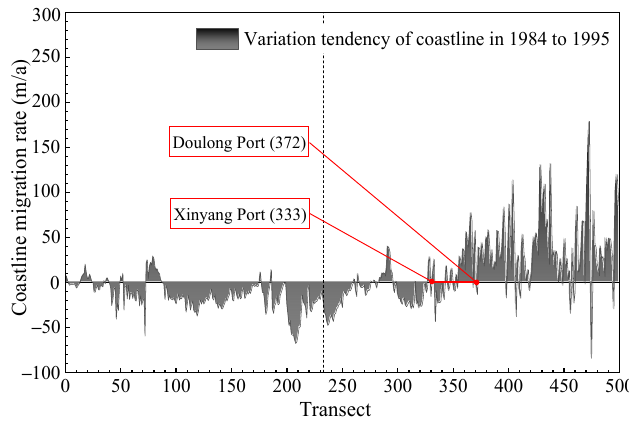
Figure 7. Variation tendency of coastline in 1984 to 1995.